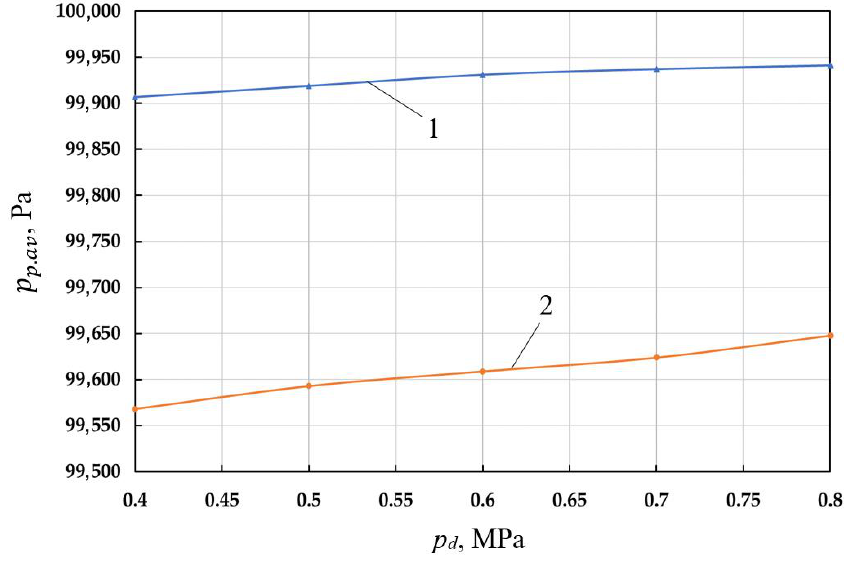
Figure 11. Dependence of average pressures per cycle in cavities 21 (1— p p2.av ) and 22 (2— p p1.av ) on the discharge pressure.